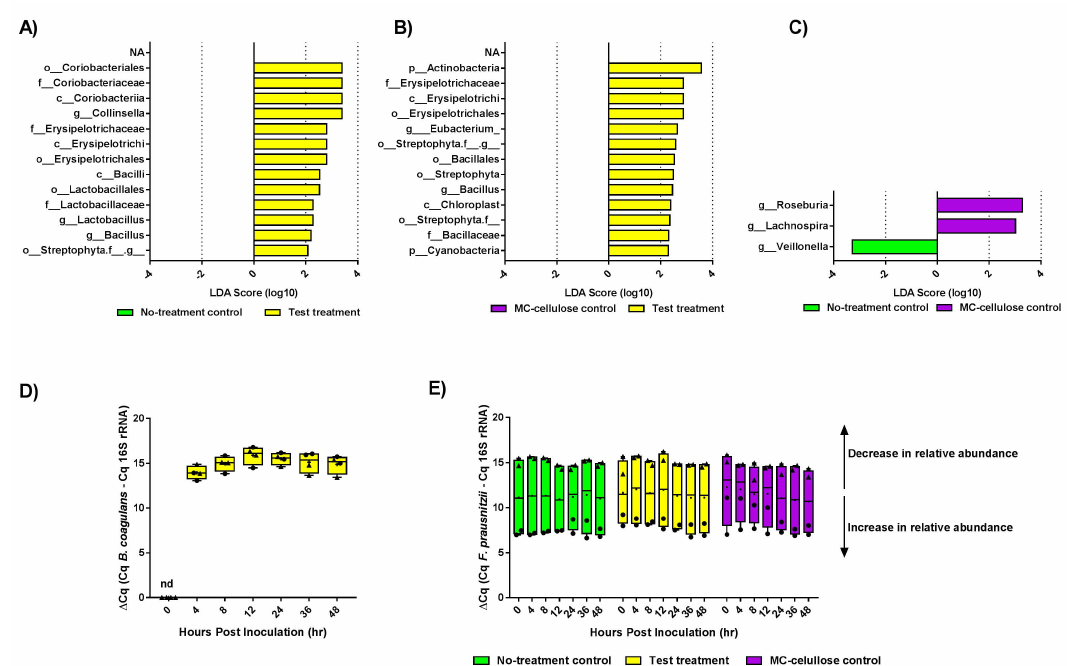
Figure 4. The test formulation modulates gut microbiota composition. ( A – C ) Histograms of the linear discriminant analysis (LDA) scores showing microbial taxa that vary significantly in abundance between: ( A ) no-treatment control and test treatment, ( B ) microcrystalline cellulose control and test treatment, ( C ) no-treatment control and microcrystalline cellulose treatment. ( C , D ) Relative abundance charts for target species: ( D ) relative abundance of inoculated probiotic, B. coagulans , over 48 h with test treatment; ( E ) relative abundance of F. prausnitzii over 48 h with no-treatment control, microcrystalline cellulose control treatment and test treatment. Triangle symbols indicate donor 1 samples and circles for donor 2